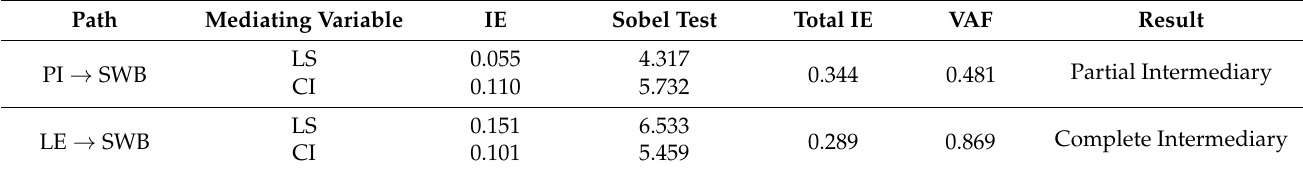
Table 7. The mediating results of the hypotheses.